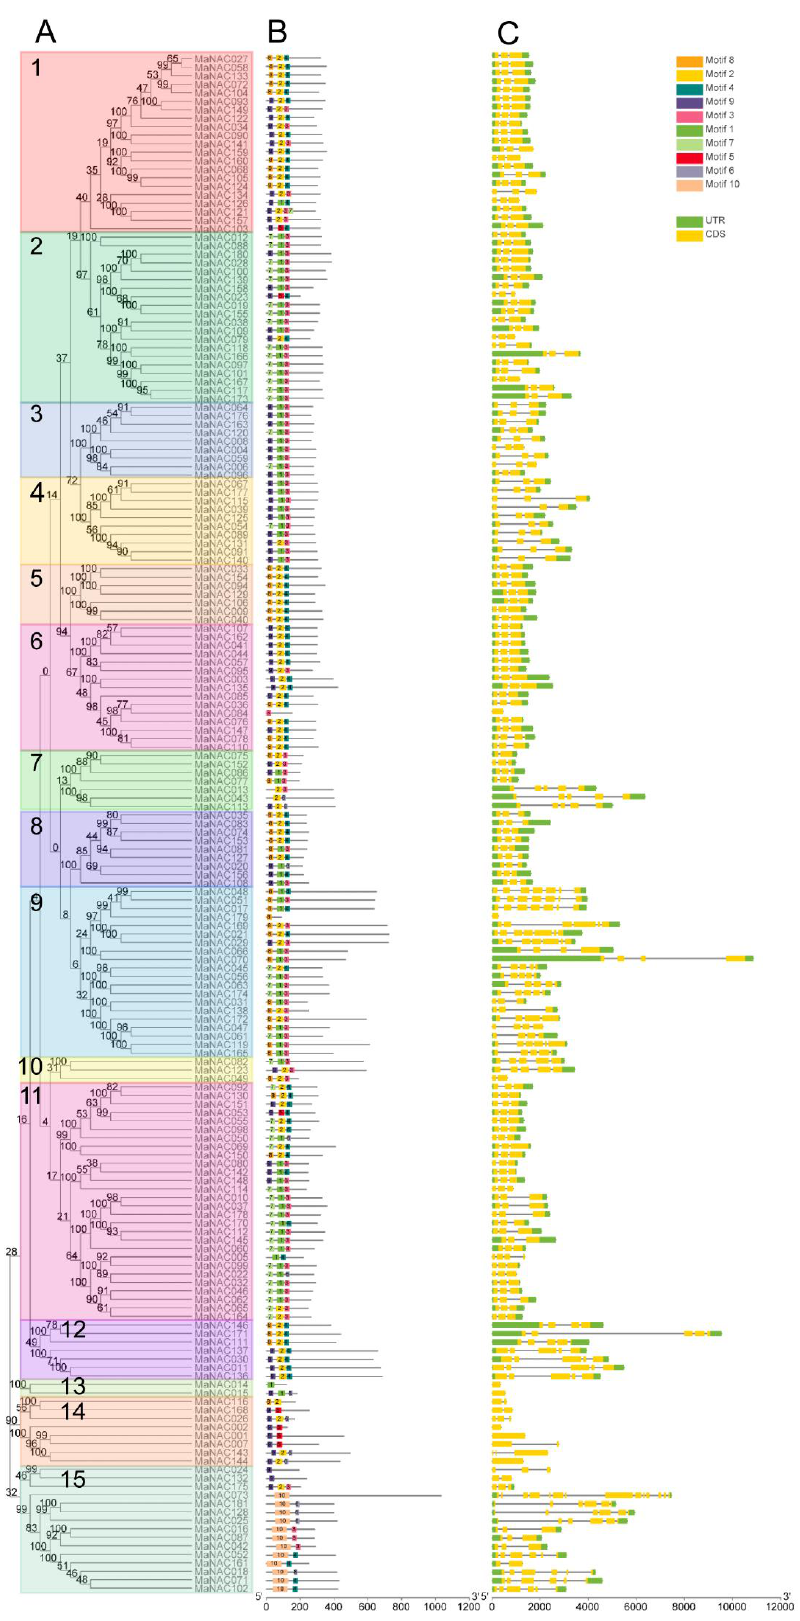
Figure 4. Phylogenetic relationships, motif compositions, and gene structure of banana NAC